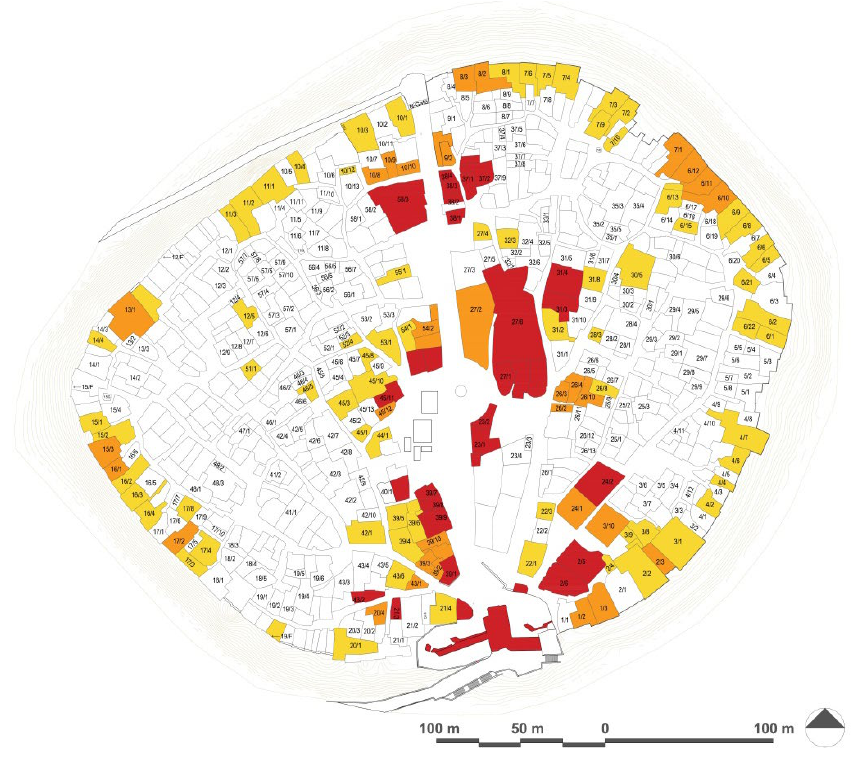
Figure 7. The selected case studies in the